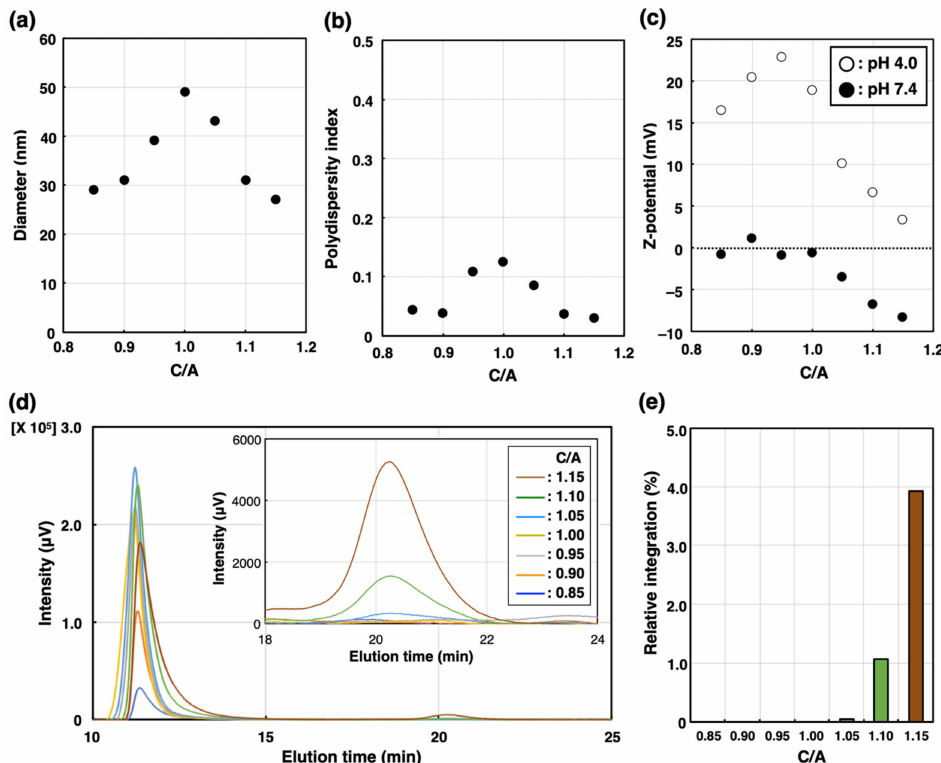
Figure 1. Characterization of PIC/m prepared with different mixing molar ratios of C/A in the range from 0.85 to 1.15 in 10 mM phosphate buffer (0 mM NaCl). ( a ) Diameter, ( b ) polydispersity index and ( c ) Z-potential (open circles denote pH = 4.0, closed circles denote pH = 7.4) are determined by DLS. ( d ) Chromatogram traces of PIC/m were measured by SEC. Brown, green, light blue, yellow, gray, orange and blue colored lines indicate C/A = 0.85, 0.90, 1.00, 1.05, 1.10 and 1.15, respectively. ( e ) Relative peak area of block copolymers (elution peak around 21 min) normalized to micelle peak area to that of PIC/m (elution peak around 11